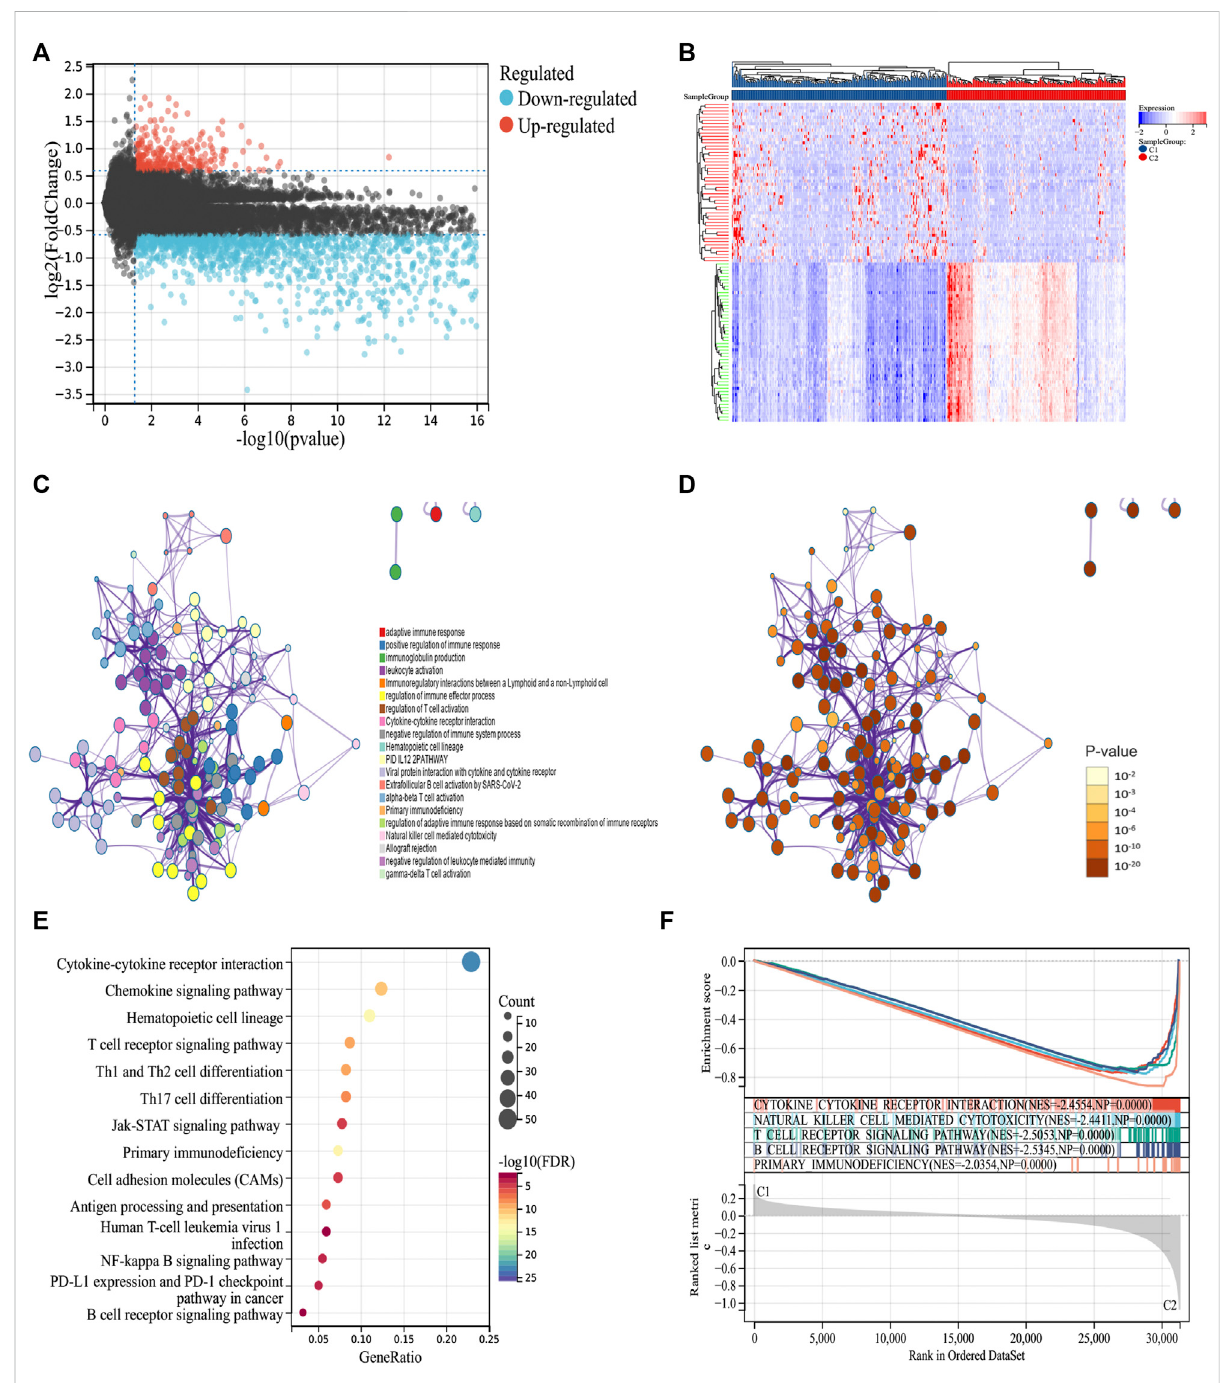
FIGURE 2 Identifying differentially expressed genes (DEGs) and biological pathways between thetwo subtypes. (A) Volcano map showing the distribution of DEGs between C1 and C2, where red represents high expression and blue represents low expression. (B) Heatmap showing the expression of DEGs between the two subtypes. (C,D) Metascape enrichment network displaying the gene function enrichment of DEGs, where each cluster annotationiscolorcoded. (E) AbubbleplotshowingtheenrichmentofsignalpathwaysofDEGs. (F) GSEAanalysisidentifyingtheenrichmentof different pathways between C1 and